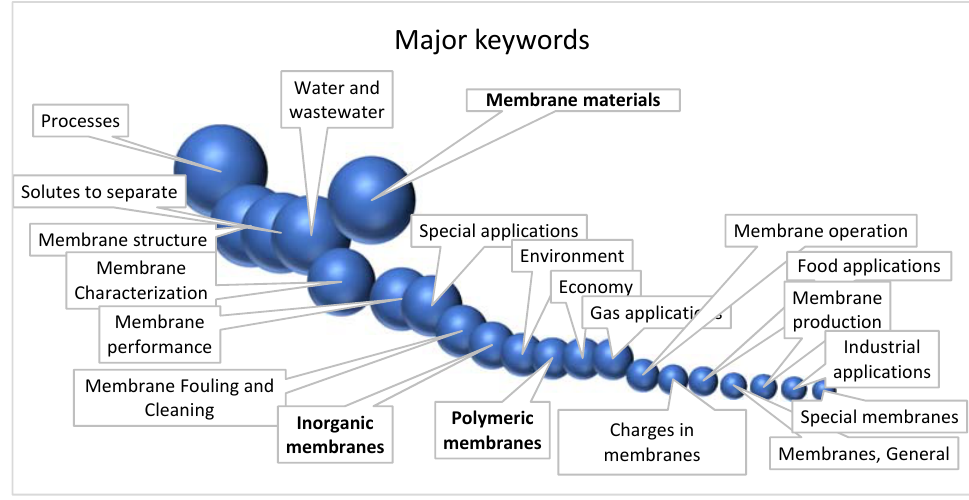
Figure 5. Comparative plot of relative number of papers according to the title keywords.